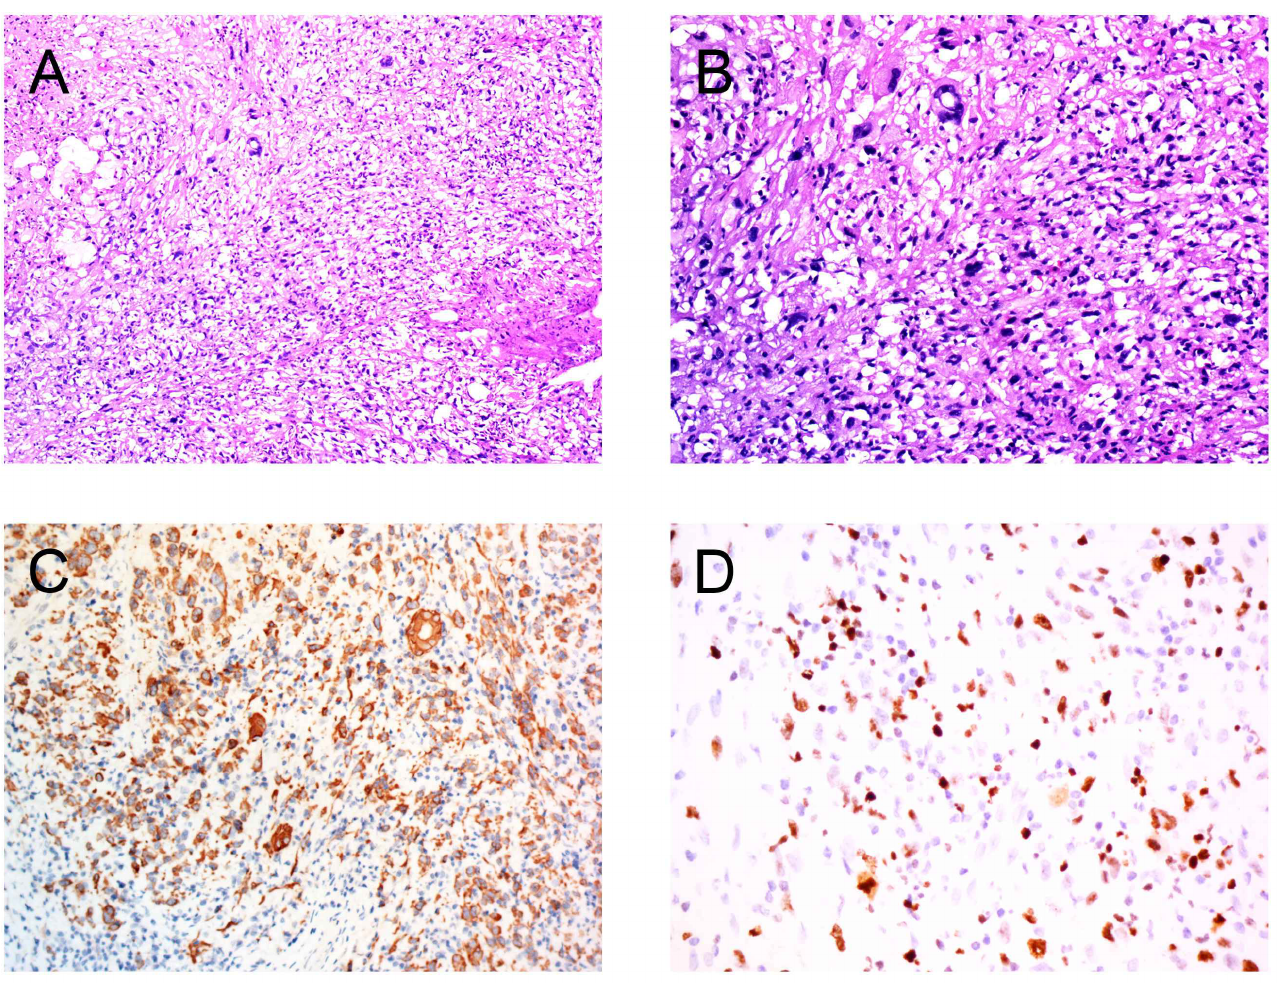
FIGURE 3. Representative pathological and immunohistochemical images of the second surgery specimen. (A) HE staining (10 × ). (B) HE staining (20 × ). (C) CK staining. (D) Ki-67